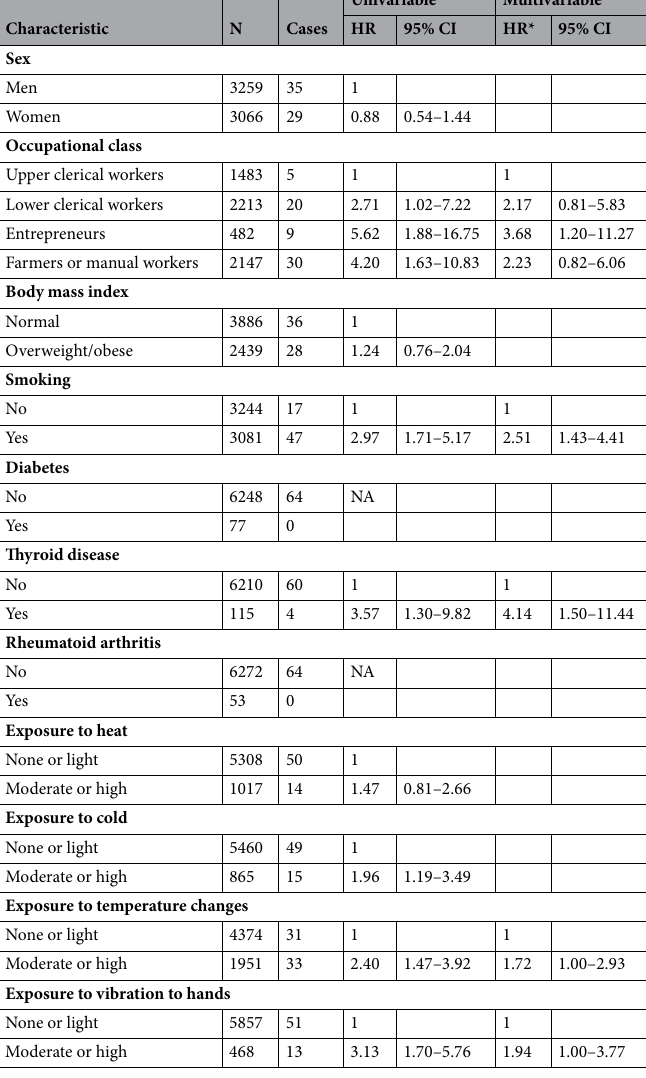
Table 2. Univariable and multivariable hazard ratios (HR) with 95% confidence intervals (CI) of hospitalization for ulnar nerve entrapment in total study sample (N = 6325). *Adjusted for variables with P value ≤